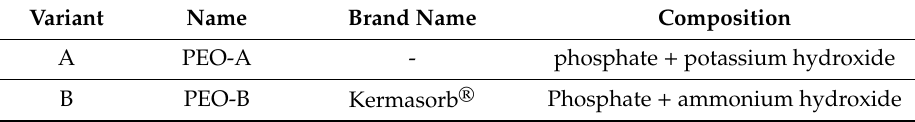
Table 2. Magnesium variants used in the experiments. PEO, plasma electrolytic